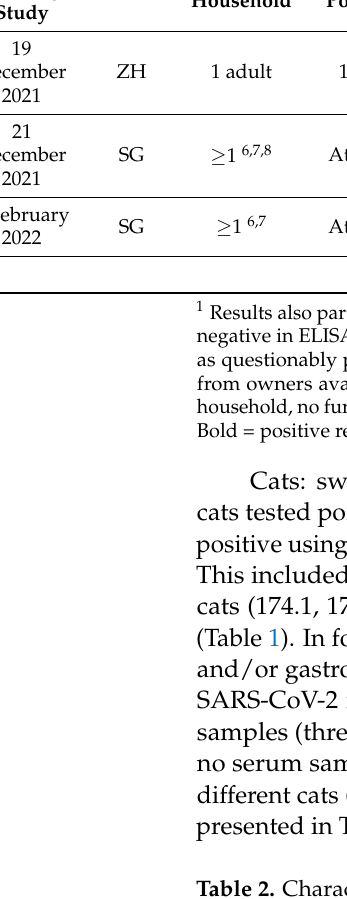
Table 2. Characteristic of all cats living in the SARS-CoV-2 Delta-lineage-positive households and clinical signs